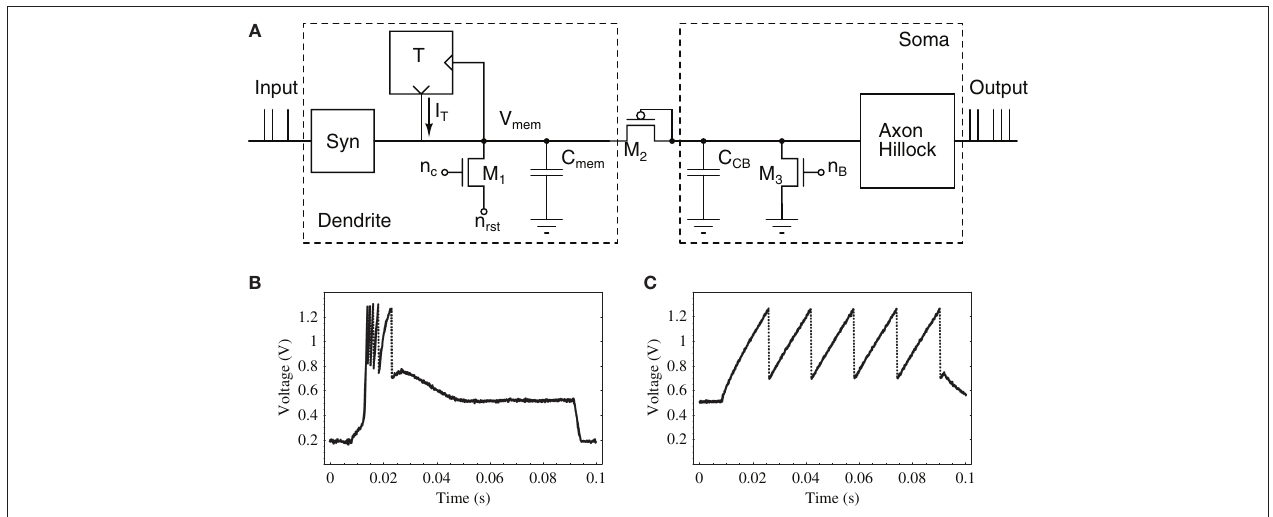
FIgure 8 | Two-compartment Thalamic relay neuron model. (a) Neuron circuit. (b,C) Dendritic voltage ( V modes: burst (b) and tonic (C) . An 80-ms wide current step is injected into the dendritic compartment at 10 ms in both